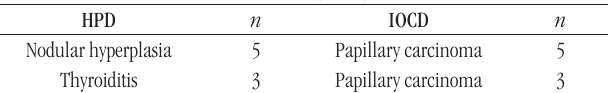
taBLE 1 – IOC of thyroid lesions at Inca from January 2001 to December